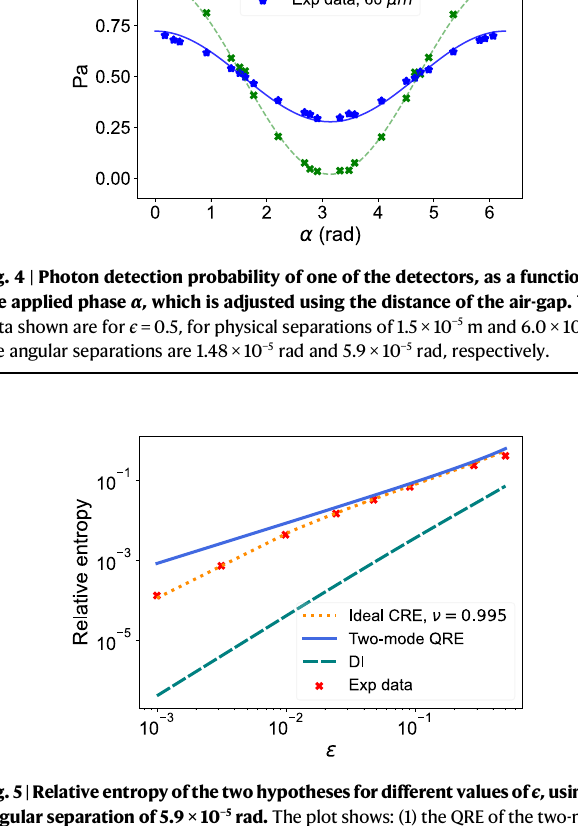
Fig.5|Relativeentropyofthetwohypothesesfordifferentvaluesof ϵ ,usingan angularseparation of5.9×10 − 5 rad. The plot shows: (1)the QREofthe two-mode state (blue solid line), (2) the CRE of the measurement maximised over α , given ν =0.995(orangedottedline),(3)theCREforshot-noiselimiteddirectimaging(DI, teal dashed line), and (4) the experimental data points (red crosses).